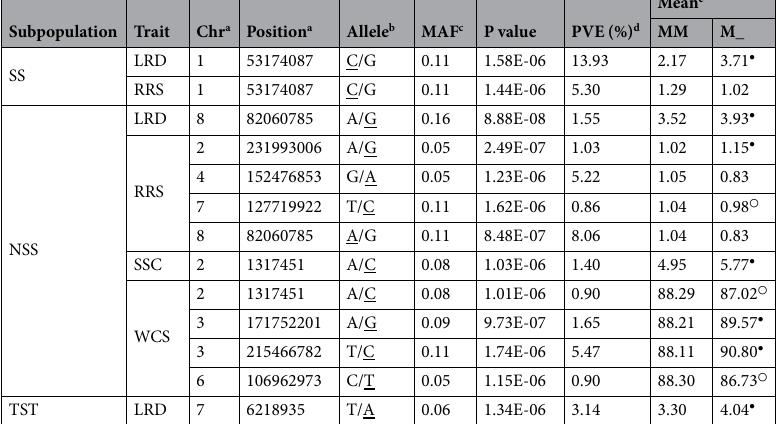
encodes a member of wall-associated kinases (WAK), which have been suggested as extracellular environment sensors that triggers intracellular signals. The expression of OsWAK98 (a RMZM2G159756 homolog) changed its homolog in Arabidopsis , EOL1 , acts collectively with EOL2 to regulate ethylene biosynthesis by controlling ACC synthase levels 27 . GRMZM2G403609 encodes a Rho GTPase activation protein (RhoGAP) with a pleck- strin homology. In rice, loss-of-function mutations in the RhoGAP protein SPIN6, which has a pleckstrin homology domain, led to programmed cell death and significantly elevated reactive oxygen species levels and and PERK1 may be involved in the general perception and response to a wound and/or pathogenic stimulus in B . napus 29 . GRMZM2G053384 is a homolog of AtLOI1 , which encodes a PPR protein involved in drought